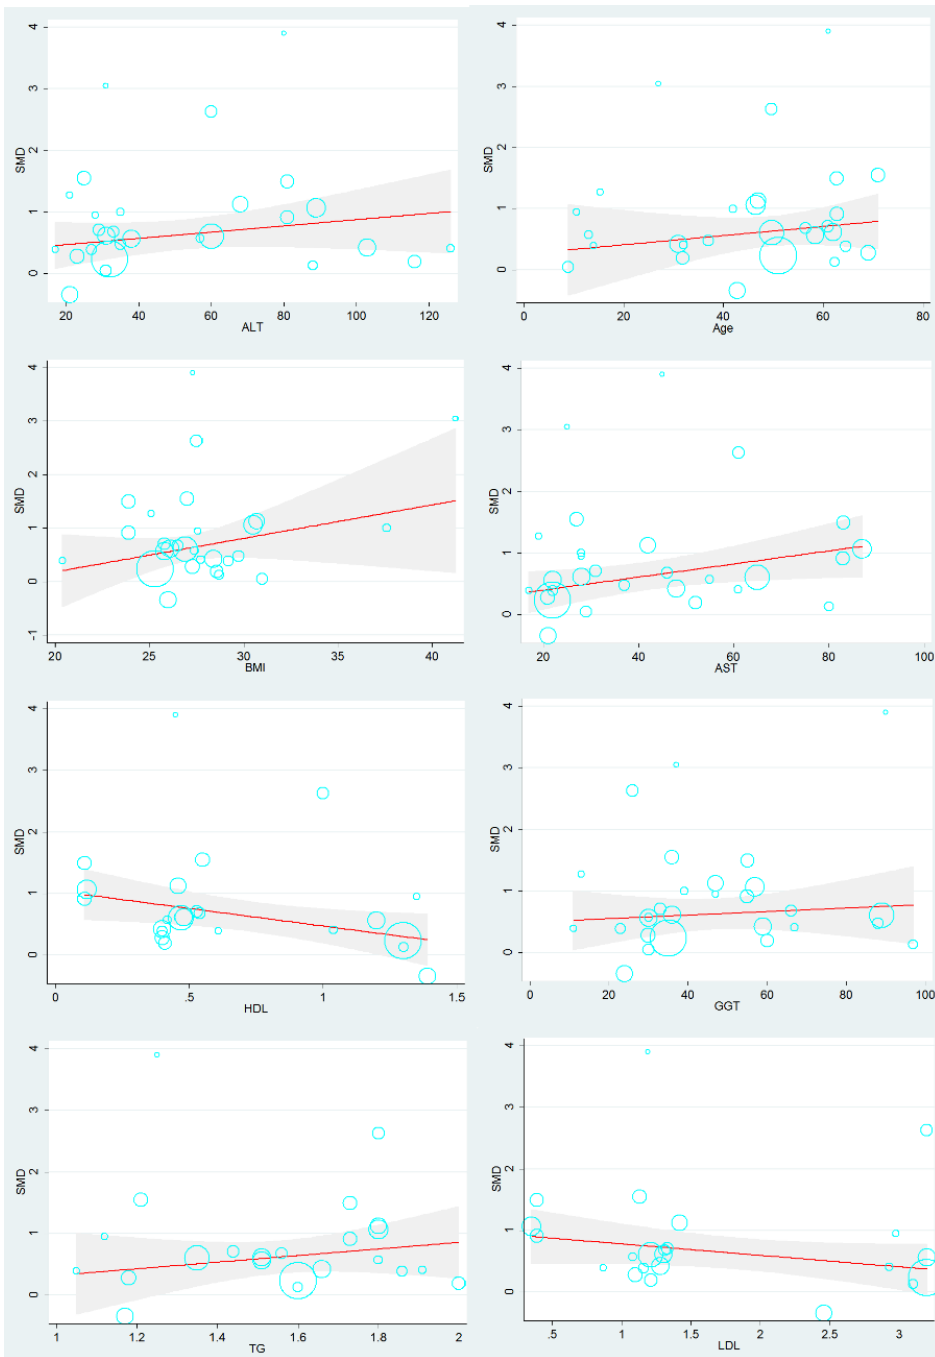
Figure 3. Dose-response relationships between clinical parameters of fetuin-A and SMD value outcomes based on data from each study. Each data point overlaps into a circle. The size of a circle represents the weight of the corresponding data point, and the larger the circle, the greater the impact. NAFLD, non-alcoholic fatty liver disease; AST, aspartate aminotransferase; ALT, alanine aminotransferase; GGT, glutamyl transpeptidase; LDL, low-density lipoprotein; HDL, high-density lipoprotein; TG, triglycerides; BMI, Body Mass Index; SMD, standardized mean difference.